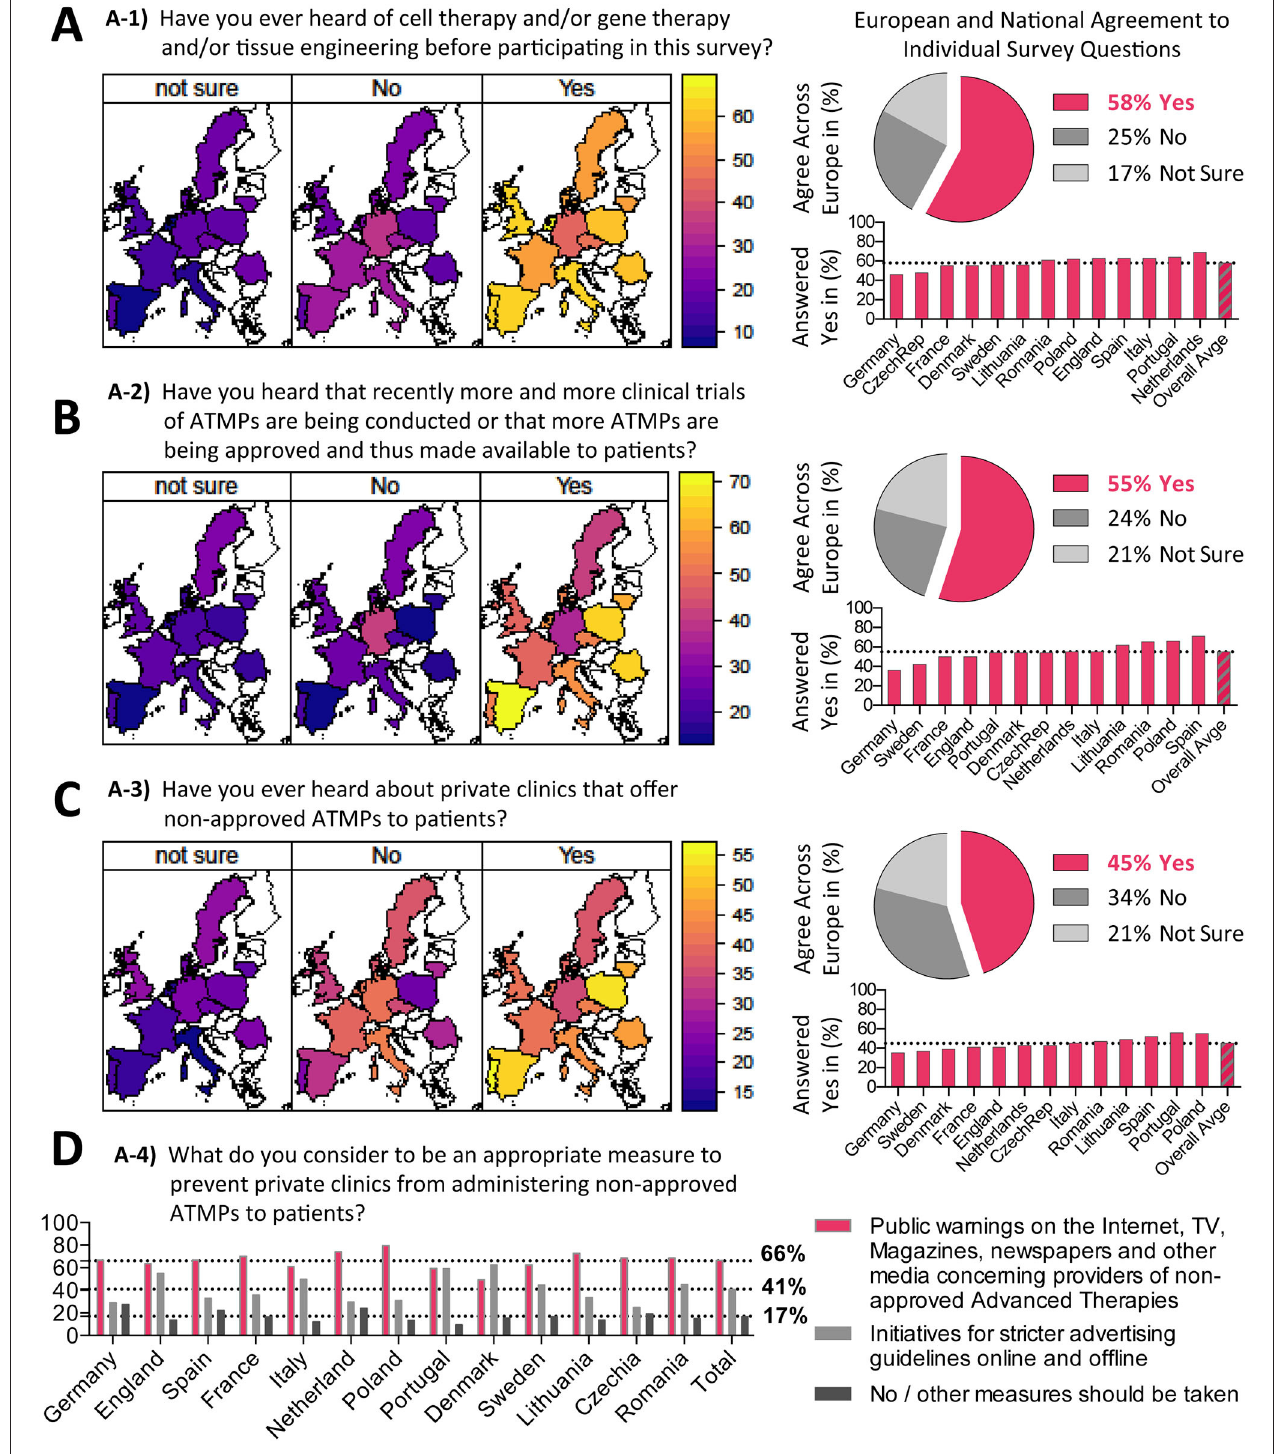
FIGURE 2 | Knowledge about ATMPs prior to survey. Results on survey topic A (see Table 1 ) sorted according to questions A1-A4. (A–C) Question A1-A3 geographical heatmaps shown to the left and corresponding numerical depiction shown to the right, with pie charts displaying the (%) agreement across Europe and bar charts displaying (%) answered yes per country. (D) Results of question A4 is displayed as bar chart (%) answered yes per country.